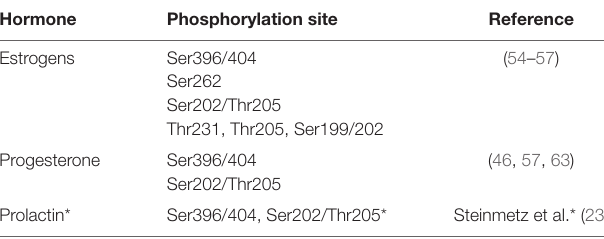
TABLe 1 | Phosphorylation sites in tau influenced by estrogen, progesterone, and